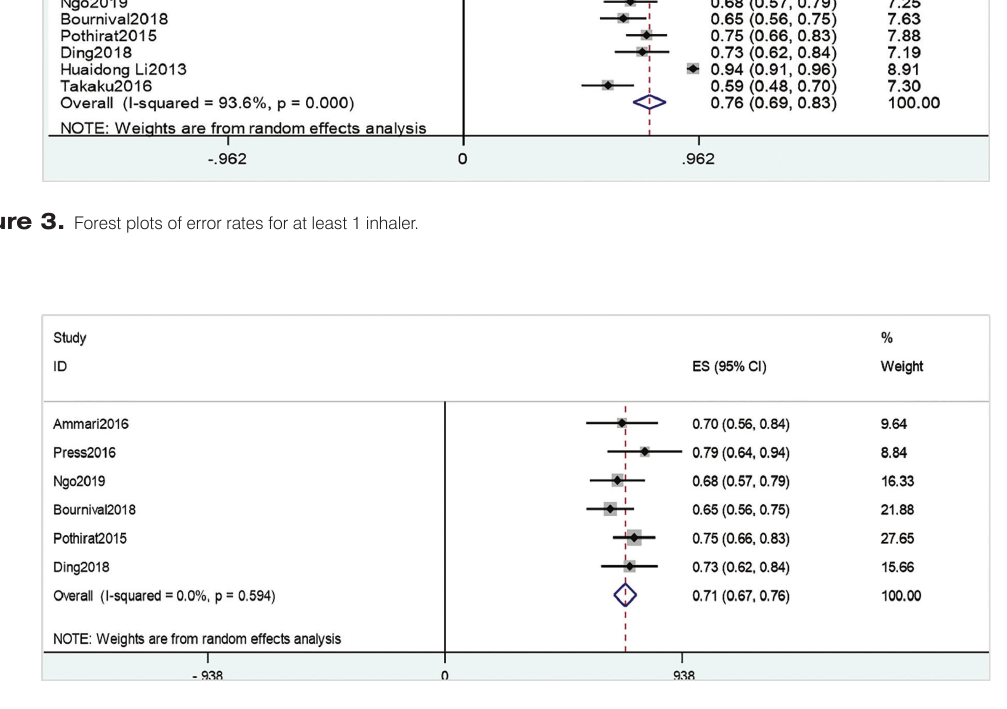
Figure 4. A cross-sectional forest map of the error rates of different inhalants.